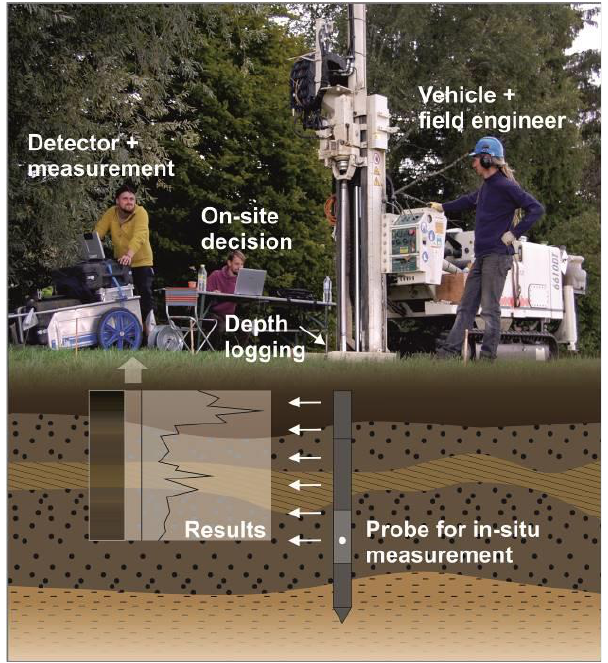
Figure 5. Application of direct push sensing in the field for in situ characterisation of sediment struc- tures.